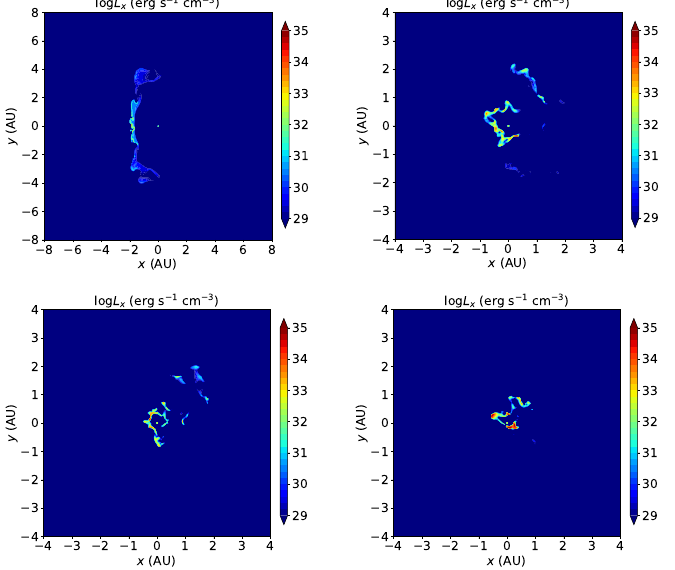
Figure 5. The 2–10 KeV X-ray emission for the simulations we run on a slice in the orbital plane. The primary is on the left side and the secondary is in the centre. Upper left: Run 1. Upper right: Run 2. Lower left: Run 3. Lower right: Run 5. For Runs 2, 3, and 5, the emission is more concentrated and the plot is zoomed in on the emission